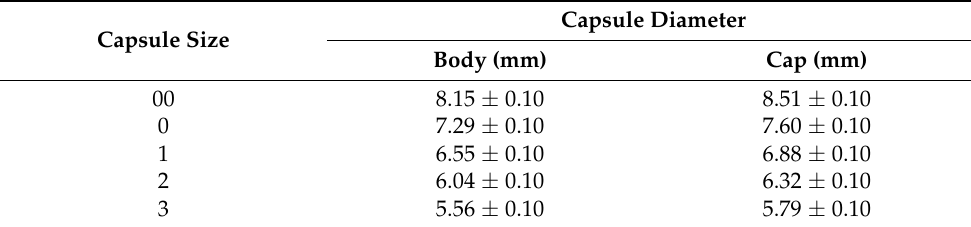
Table 6. Diameter specification of hard gelatine